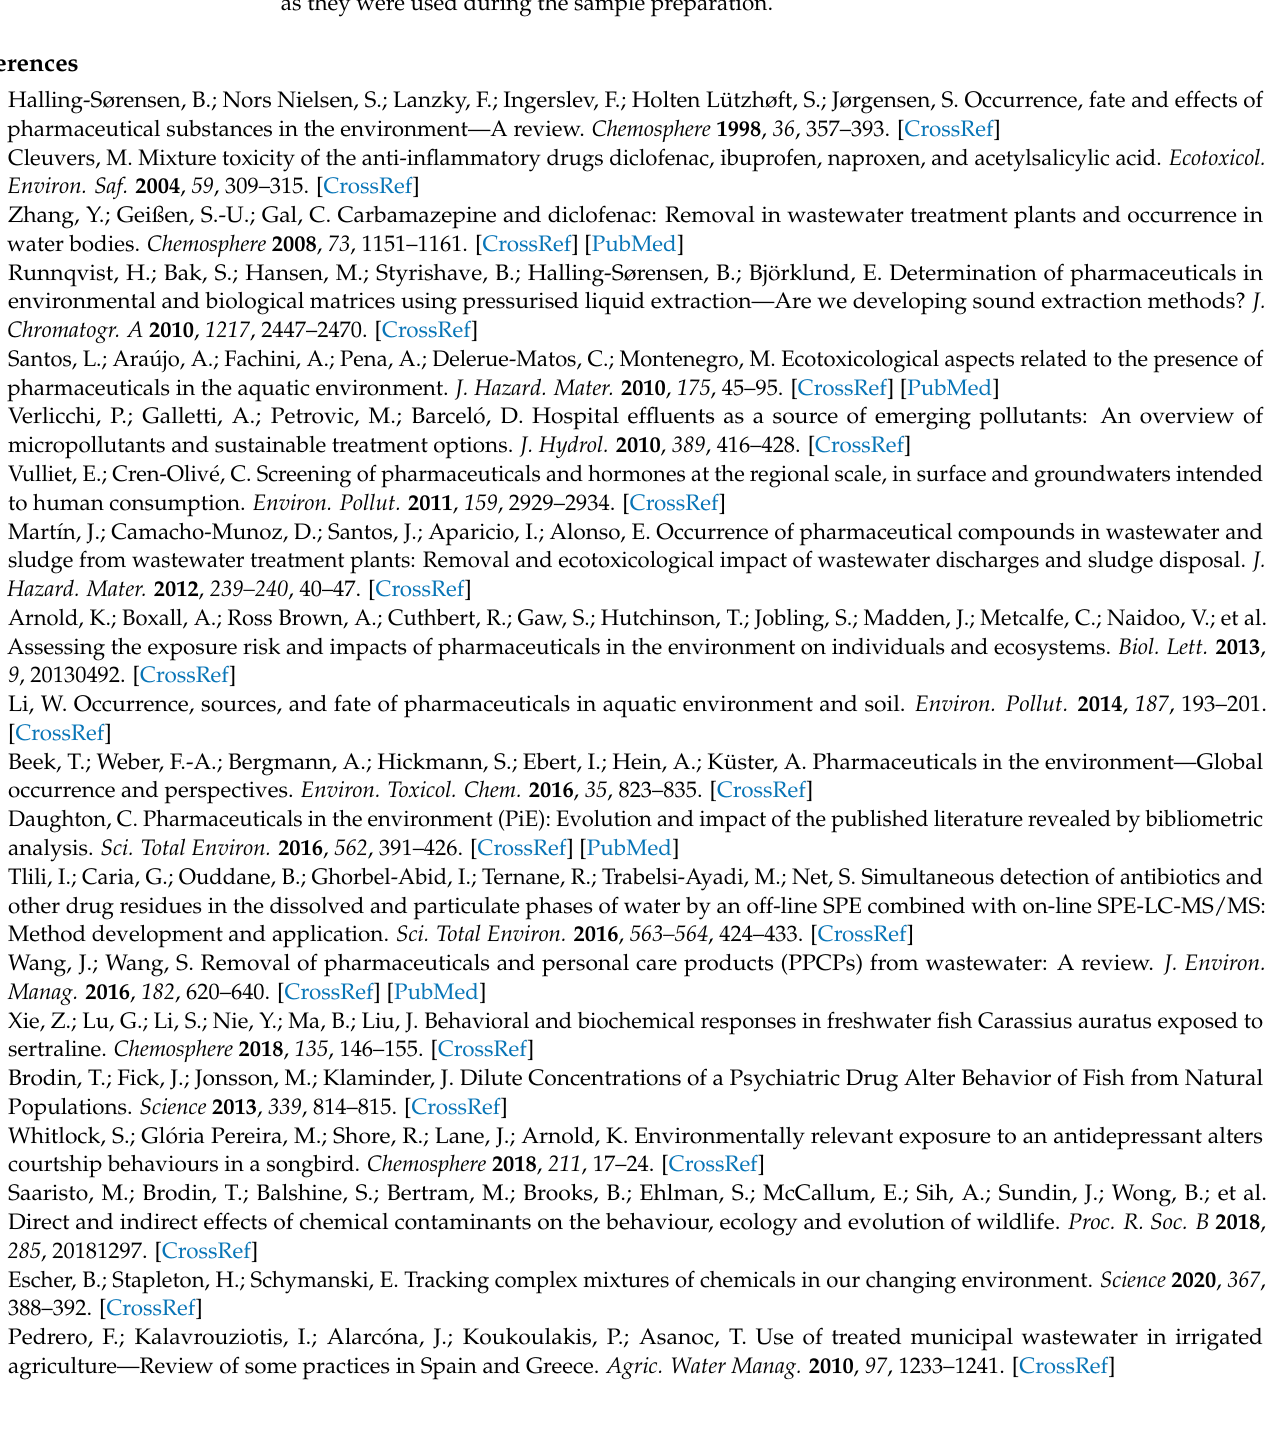
a Swedish report to Region Skåne called “ LUSKA—Läkemedelsutsläpp från Skånska Avloppsreningsverk 2017 ” by Ola Svahn and Erland Björklund. The report was later translated into English in a report with the title “ Pharmaceutical emissions from Scanian wastewater treatment plants in 2017 ”. The cost of translation was funded by Interreg South Baltic as part of the project European project “ Model Areas for Removal of Pharmaceutical Substances in the South Baltic—MORPHEUS ”, Project No. STHB.02.02.00-